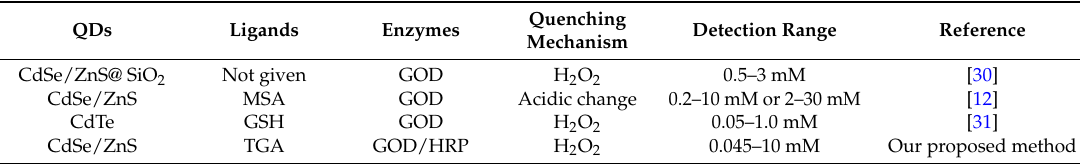
Table 1. Detection limits and ranges for optically based glucose detection using QDs.